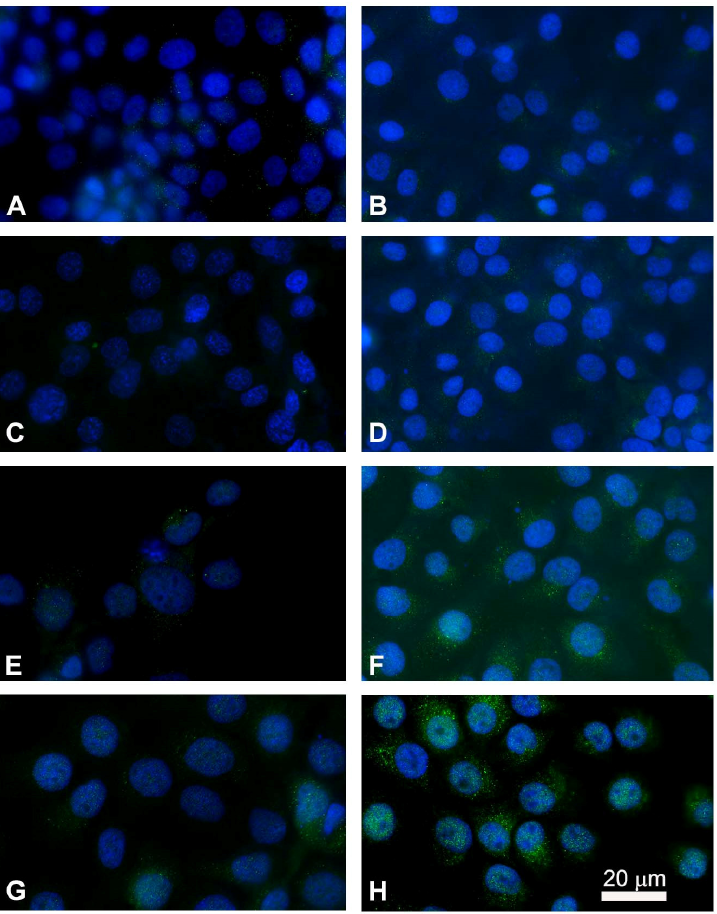
Figure 9. Immunostaining of cytochrome c with nuclear Hoechst staining in FaDu cells (left panel) and in CAL 27 cells (right panel). Intracellular distribution of cytochrome c (green) and nuclei localization (blue) were performed by fluorescence microscopy. ( A , B ) Untreated cells; ( C , D ) single electroporated cells; ( E , F ) cells treated with MMC alone (5 µM for 24 h); ( G , H ) cells treated with the combined therapy (EP + MMC). Point structures in green, localized in the cytoplasm, highlight the cytochrome c released.